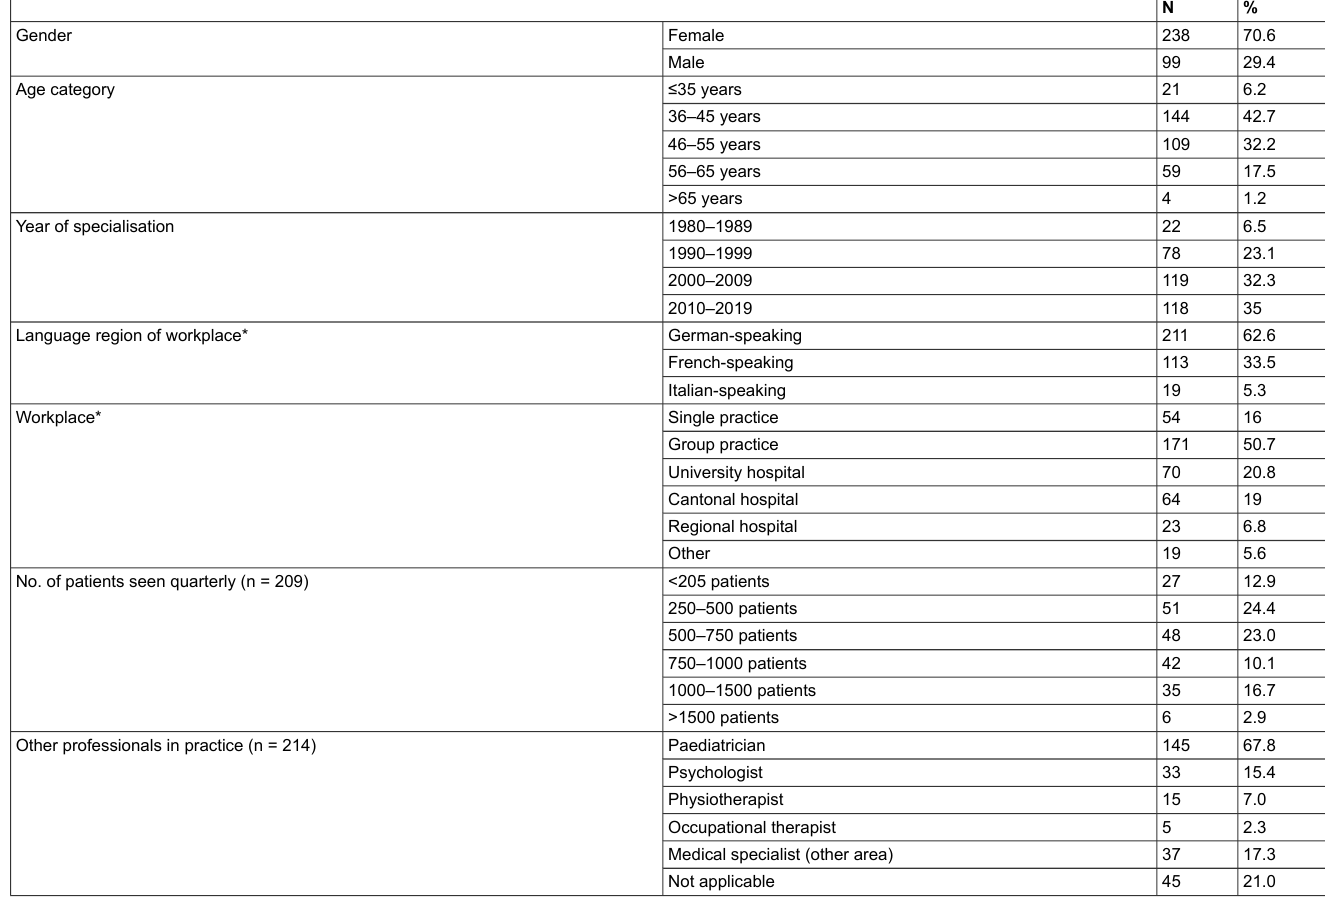
Table 1: Sociodemographic and work-related characteristics of the sample (n =